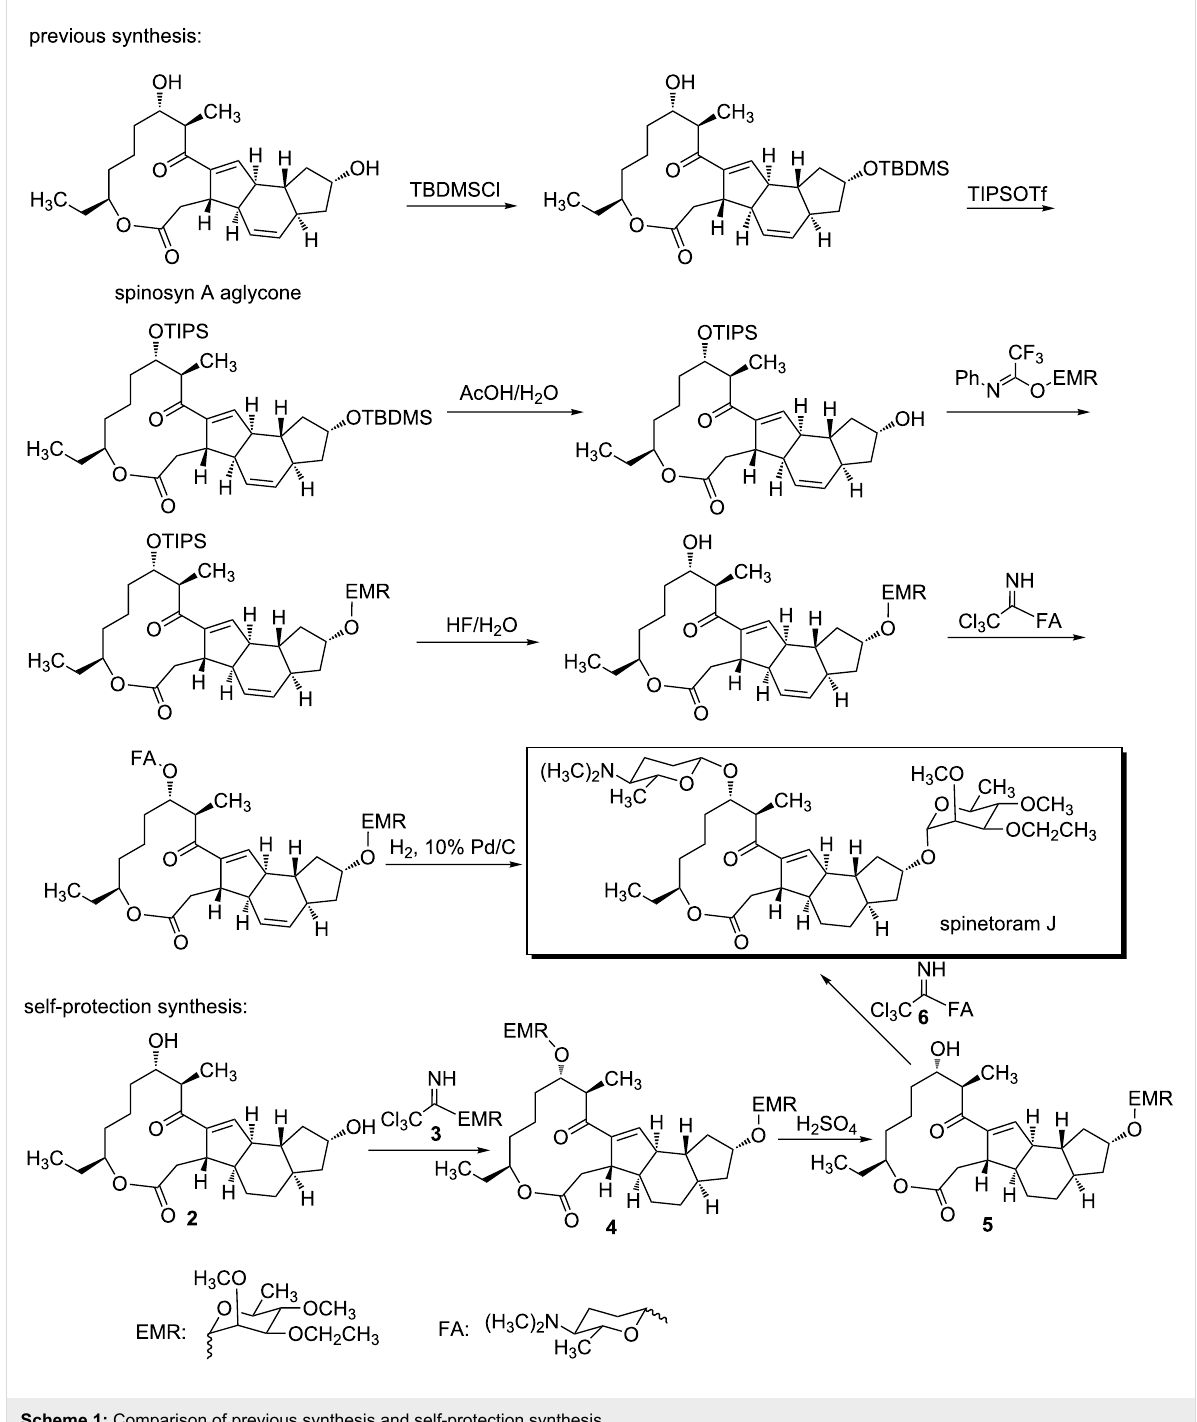
Scheme 1: Comparison of previous synthesis and self-protection synthesis.